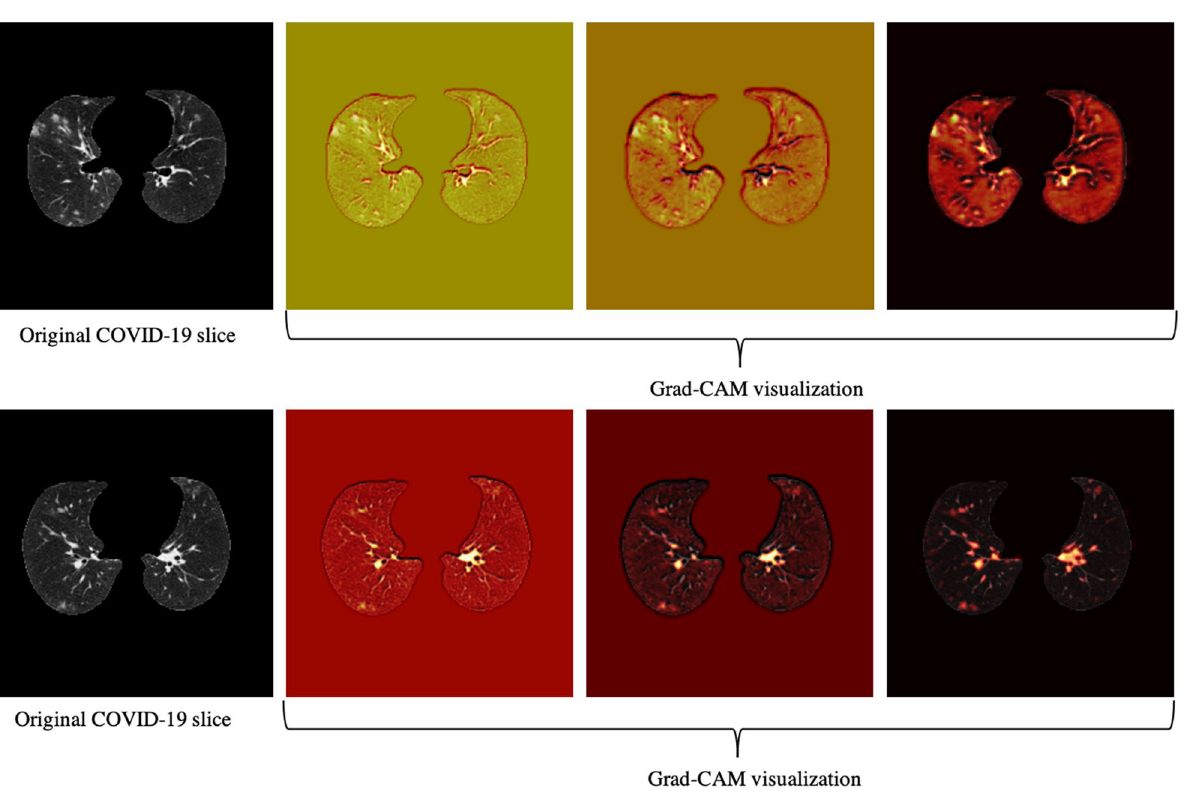
Figure 5. Grad-CAM visualization of two COVID-19 slices. This figure shows that the proposed AI model is paying attention to relevant locations of the